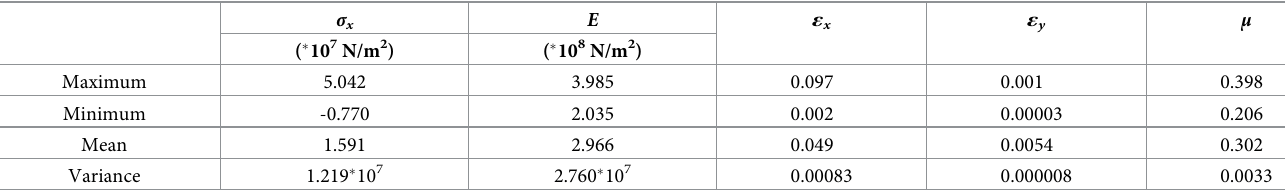
Table 6. Statistics of the parameters and variables in dataset 4.